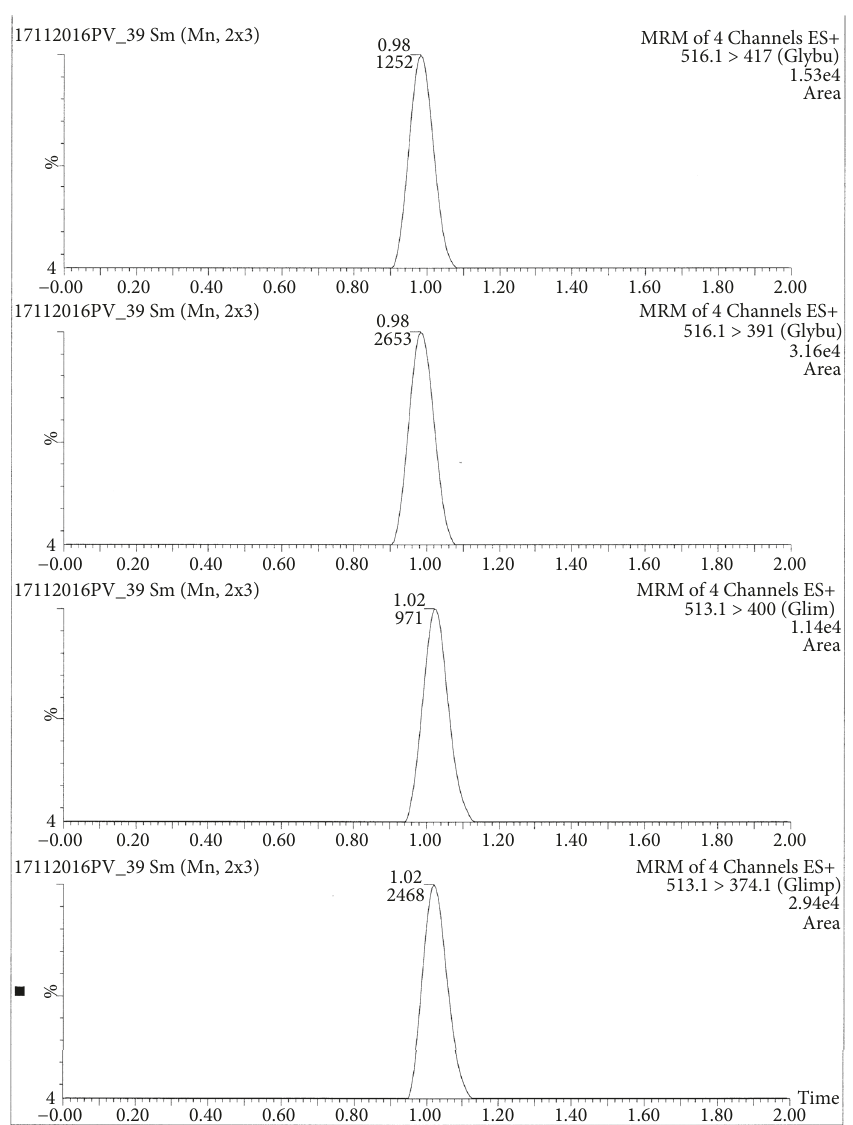
Figure 1: The representative chromatograms of daughter fragments of glibenclamide and glimepiride.